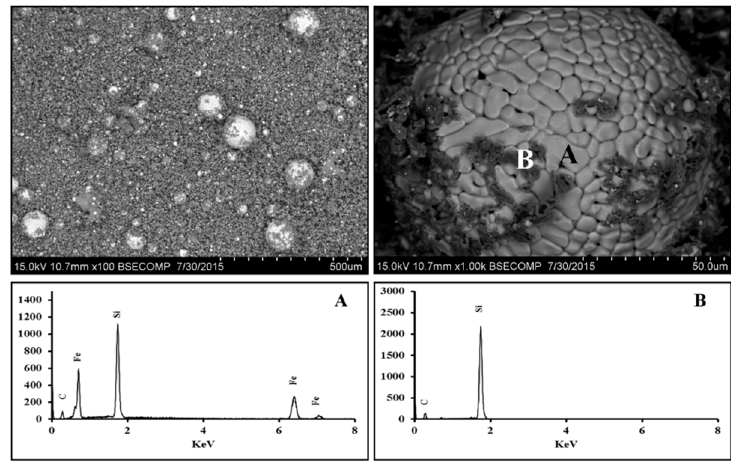
Figure 3. The presence of a large number of Fe-Si alloy droplets in a range of sizes across the specimen. The dark powder in the background is unreduced silica and or silicon carbide. Phases “A” and “B” represent ferro-silicon alloys produced in the system.